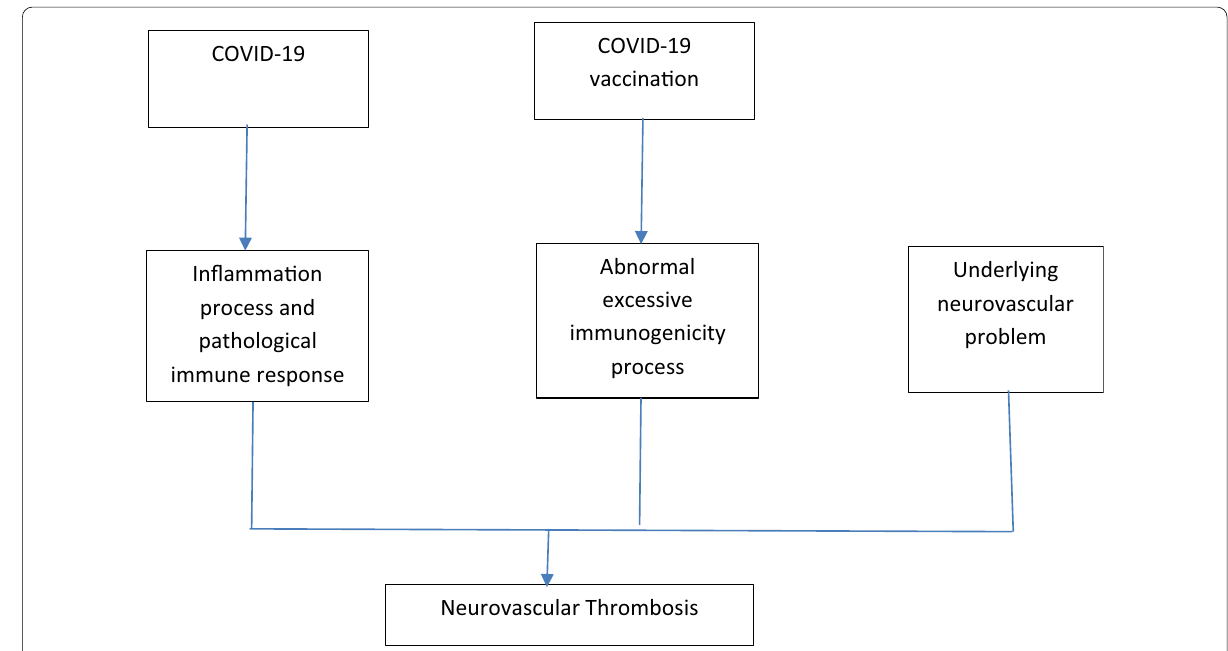
Fig. 1 Pathophysiological process that might induce neurovascular thrombosis in COVID—19/COVID-19